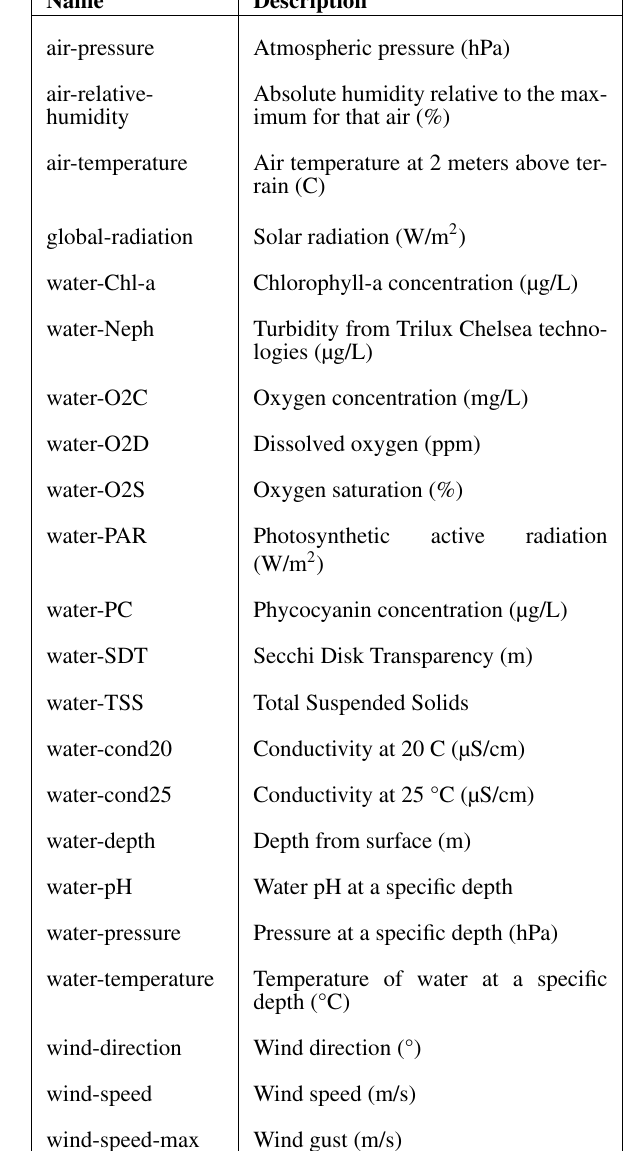
Table 2. List of observed properties registered and standardized on